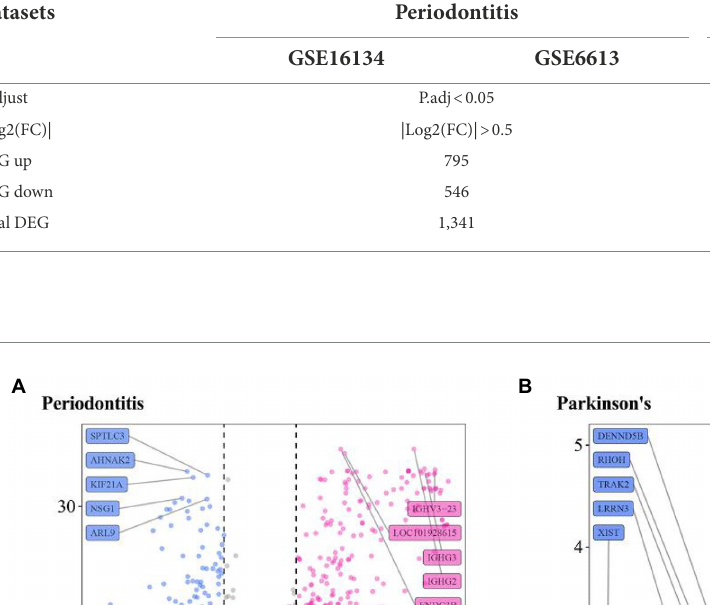
TABLE 2 DEG statistical results.